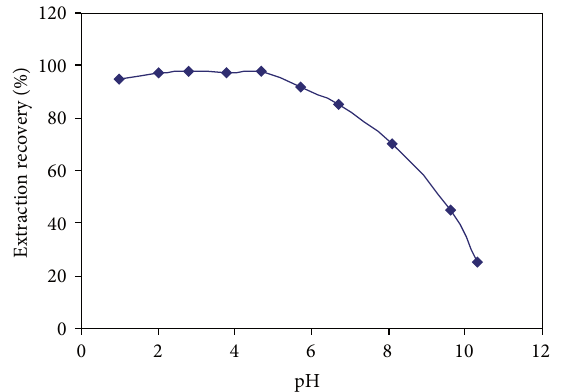
F 1: Effect of pH on extraction recovery of palladium obtained from DLLME. Extraction conditions: water sample volume, 5.0mL;